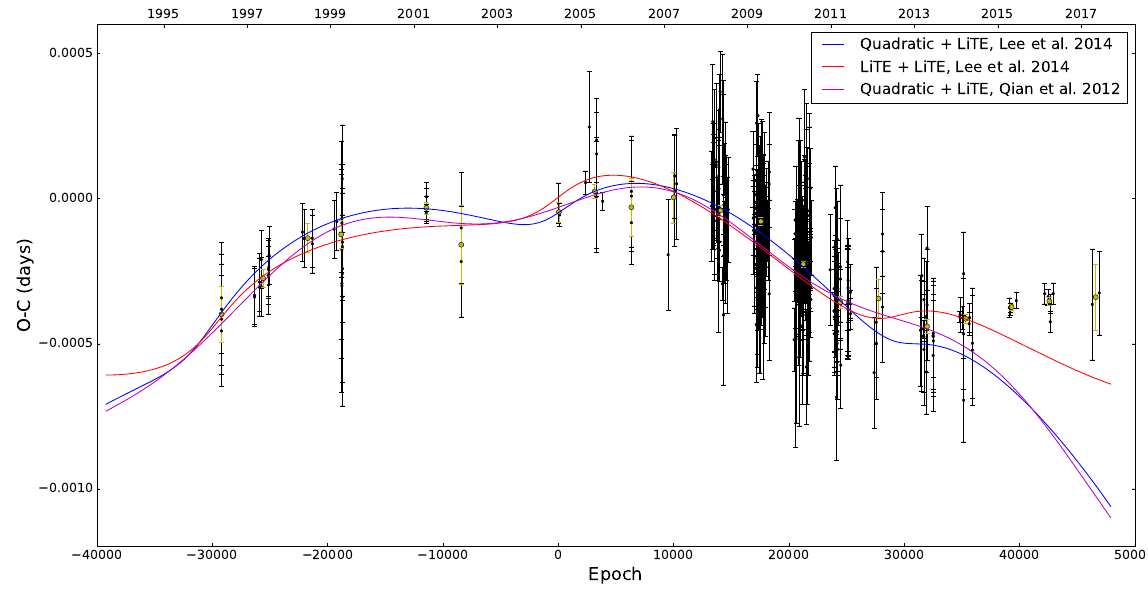
Figure 2. Eclipse Timing Variation (O-C) of NY Vir. The graph contains all the minima times that we collected from the literature and our own observations. Models are from Lee et al. (2014) (blue & red) and Qian et al. (2012) (magenta). Data points with large error bars around the epoch 20000 are from WASP Public Archive as calculated by Lohr et al. (2014).